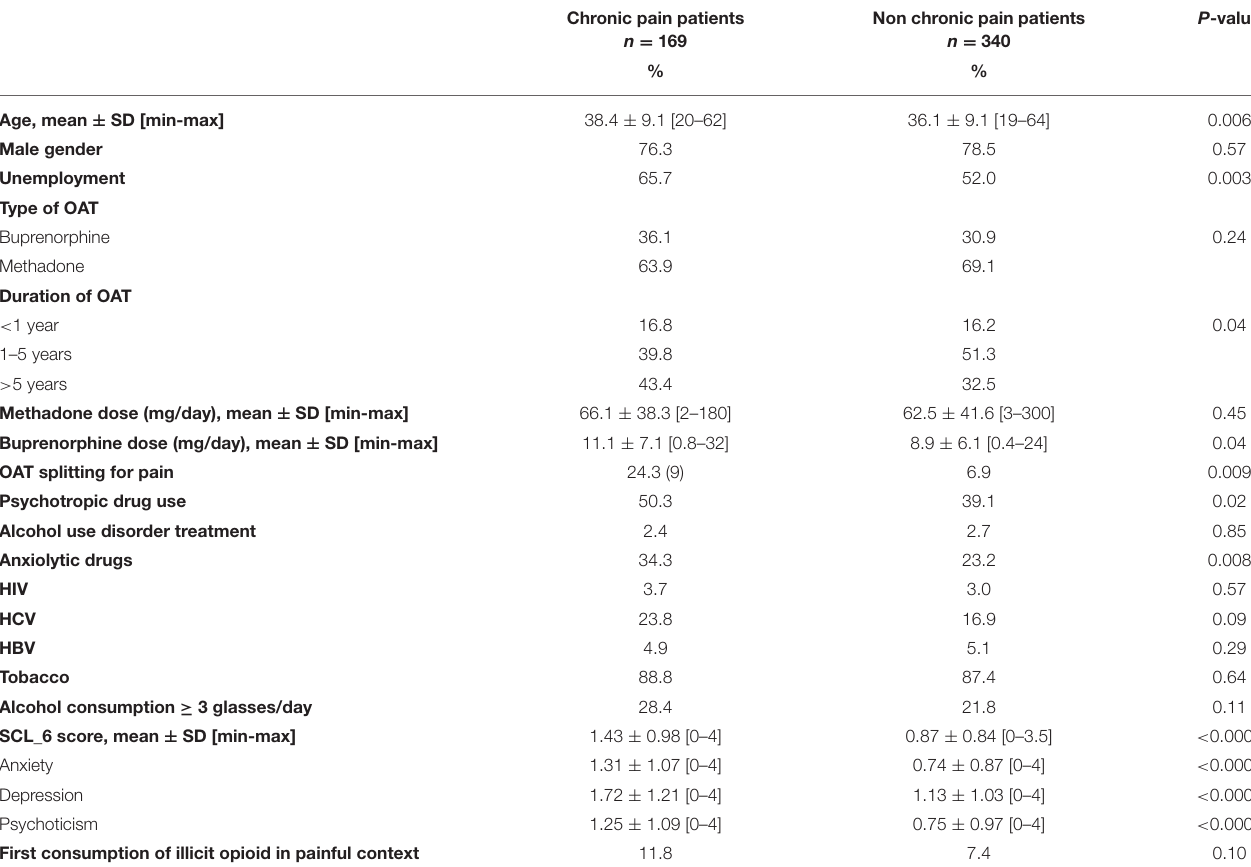
TABLE 3 | Comparison of characteristics of patients receiving OAT with chronic pain vs. patients receiving OAT without chronic pain.